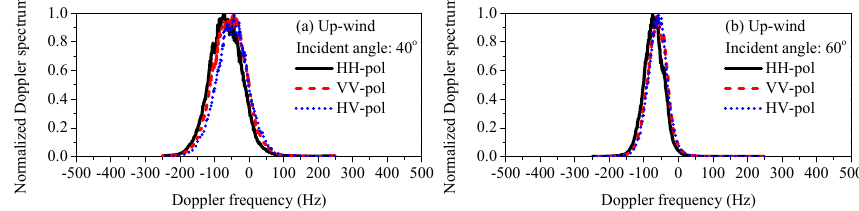
Figure 15. Comparison of Doppler spectrum at Ka-band for different polarizations and incident angles. ( a ) Incident angle 40 ◦ ; ( b ) Incident angle 60 ◦